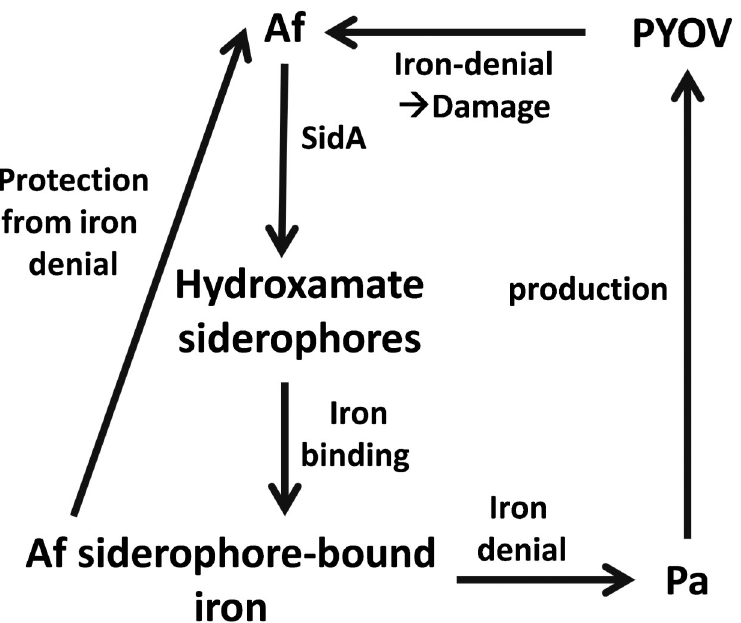
Fig 7. Summary. In need for iron P . aeruginosa (Pa) produces its siderophore pyoverdine (PYOV). PYOV-chelated iron is not available to A . fumigatus (Af), resulting in iron deficiency and damage to the fungus. Anti-fungal activity in part is counter-balanced by SidA-dependent A . fumigatus hydroxamate siderophores, providing iron to the fungus, further denying iron from P . aeruginosa .